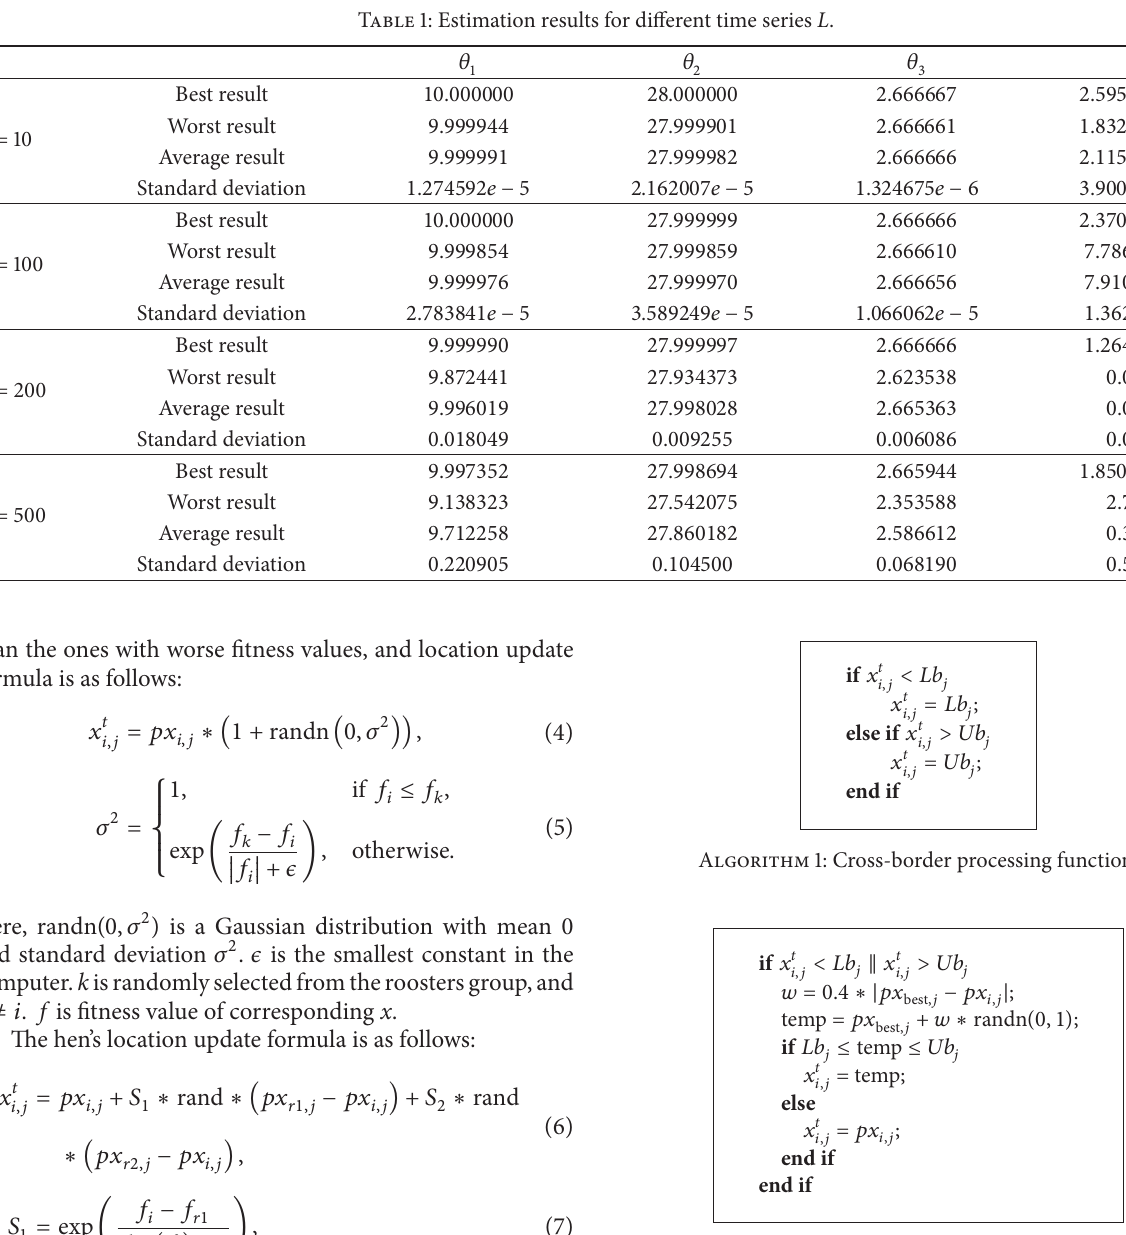
Algorithm 2: Improved cross-border processing